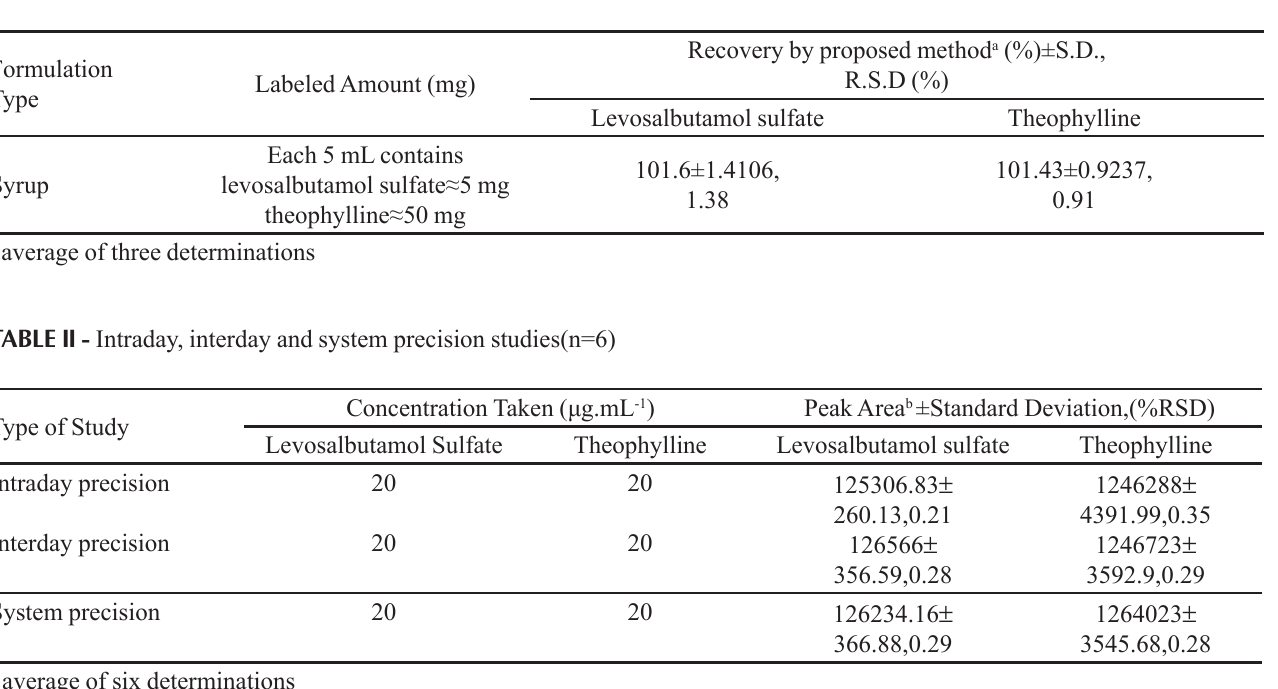
TABLE I - Analysis of syrup dosage form Formulation